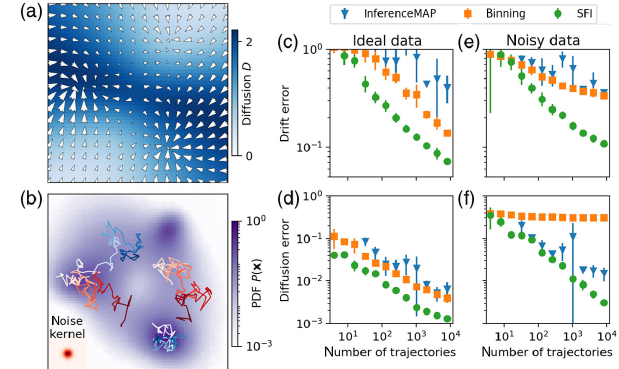
FIG. 9. Quantitative comparison of SFI with other methods on a simulated system mimicking 2D single-molecule trajectories in a complex cellular environment with multiple potential wells, out- of-equilibrium circulation, and space-dependent isotropic diffu- sion. (a) The diffusion field (blue gradient) and drift field (white arrows, scaled as j Φ j 1 = 2 for better legibility). (b) The steady-state probability distribution function (PDF) of the process. The blue traces show two representative trajectories with n ¼ 100 time steps. The red traces show trajectories blurred by moderate Gaussian measurement error (with amplitude shown as a red kernel). (c) – (f) Comparison of the performance of SFI with adaptive Fourier basis (green circles) and two widely used inference methods: I nference MAP [25], a Bayesian method for single-molecule inference (blue triangles), and grid-based bin- ning with maximum-likelihood estimation [23,33] [Eq. (7)] and an adaptive mesh size (orange squares). We evaluate the perfor- mance of these methods on the approximation of the drift field [(c),(e)] and diffusion field [(d),(f)] as a function of the number N of single-molecule trajectories [similar to those in (b)] used, with ideal data [(c),(d)] and in the presence of measurement noise [(e), (f)]. The performance is evaluated as the average mean-squared error on the reconstructed field along trajectories. SFI outper- forms both other methods in all cases; for noisy data, SFI is the only one that provides an unbiased estimation of the drift. Details and parameters in Appendix H